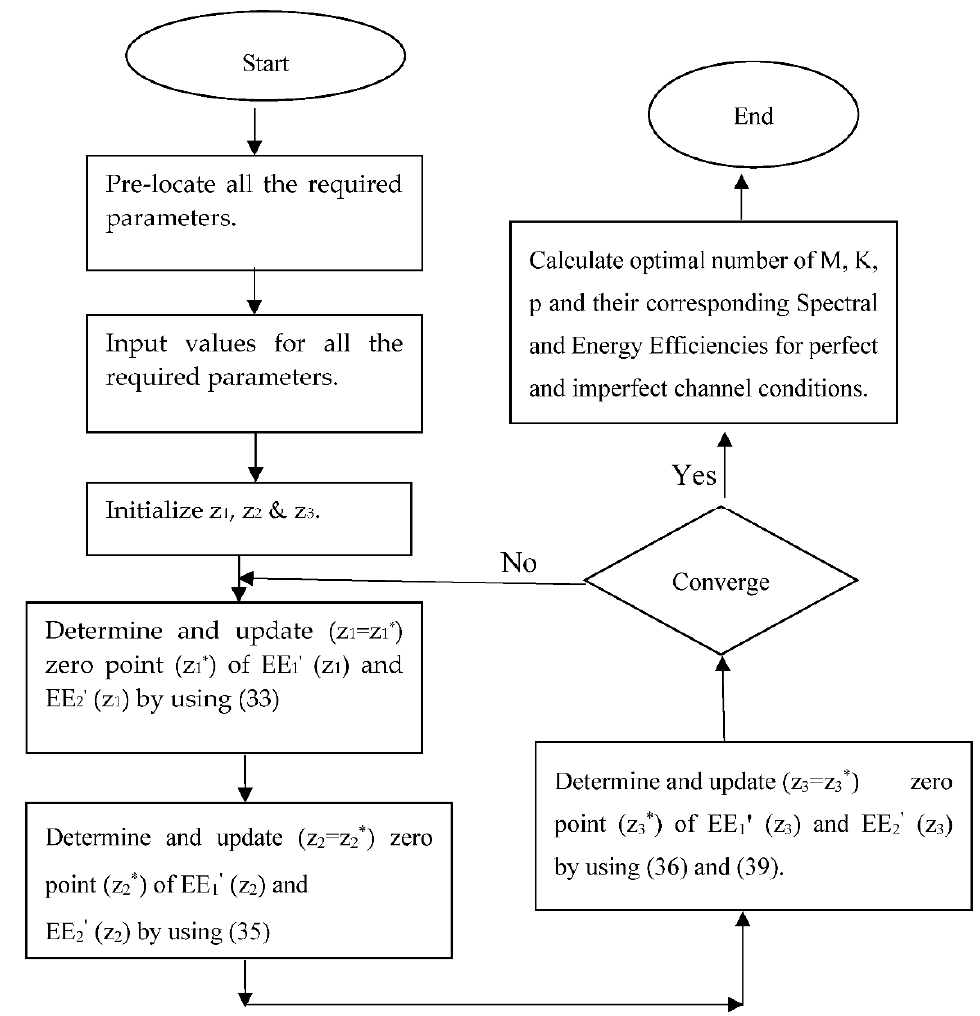
Figure. 3. Alternative numerical algorithm for solving the optimization problem. Figure 3. Alternative numerical algorithm for solving the optimization